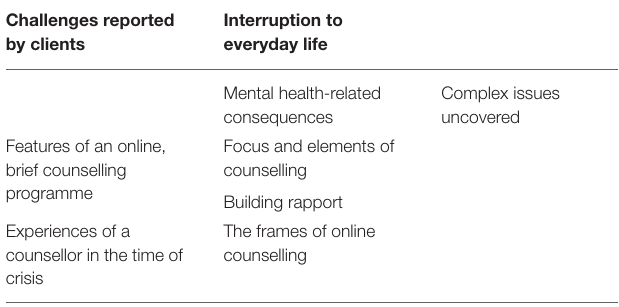
TABLE 3 | Summary of counsellor